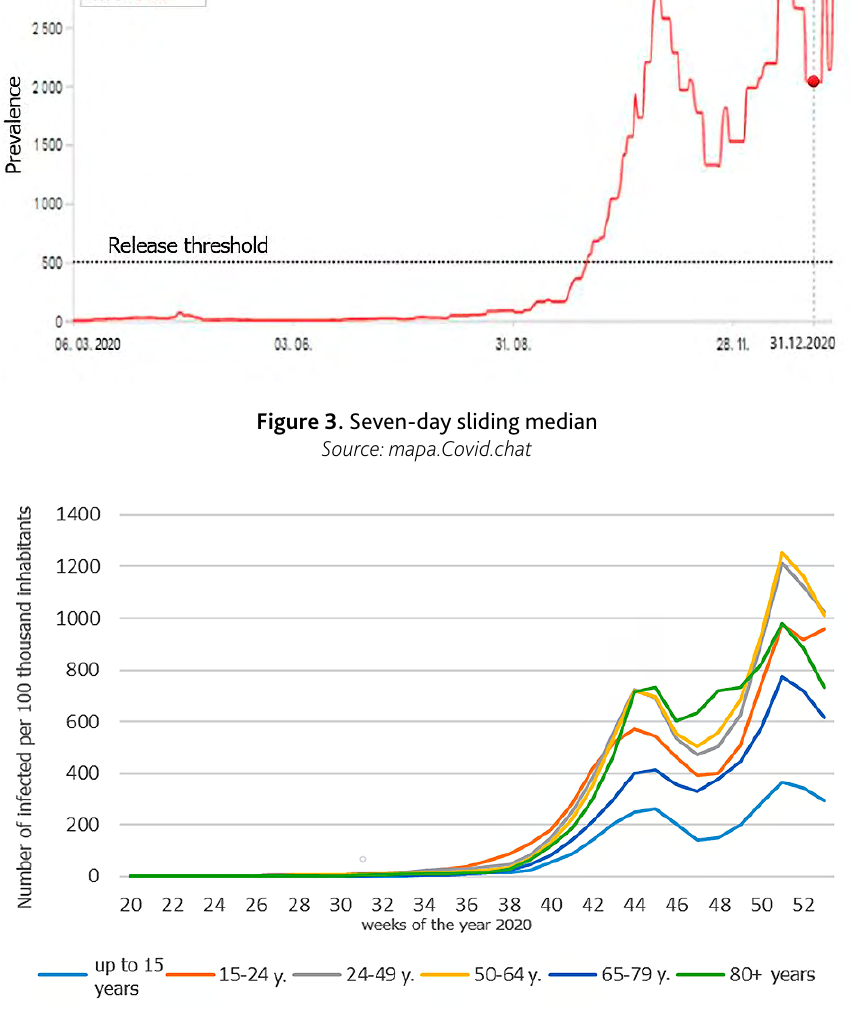
Figure 4. Fourteen-day specific incidence according to age